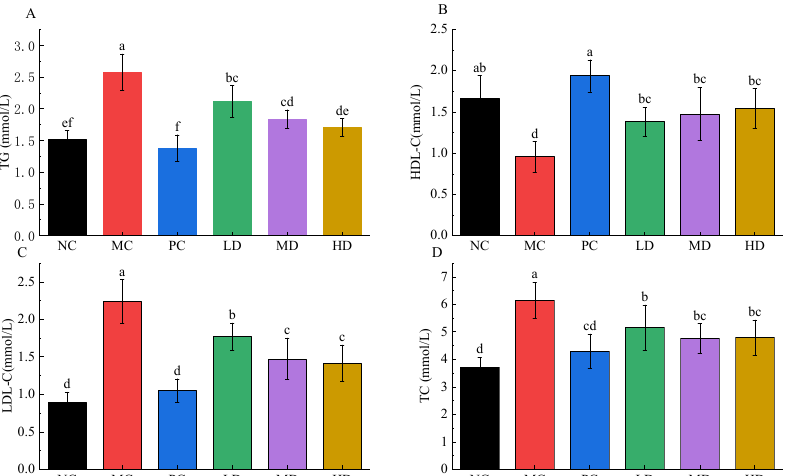
Figure 3. Lipid profiles in mice fed experimental diets for 30 days. Serum levels of TG ( A ); HDL-C ( B ); LDL-C ( C ) and TC ( D ) were measured in the experimental mice. Values are displayed as a bar chart plot with means (expressed as ‘+’), n = 3. a–f: bars with different letters are significantly different at p < 0.05 by Tukey’s post hoc test. NC: normal group (normal feed, 0.9% saline); MC: model group (HFD, 0.9% saline); PC: positive group (HFD, 0.5 mg/mL xuezhikang capsules); LD: RFV low dose group (HFD, 10% RFV); MD: RFV medium dose group (HFD, 30% of RFV); HD: RFV high dose group (HFD, 50% of RFV).